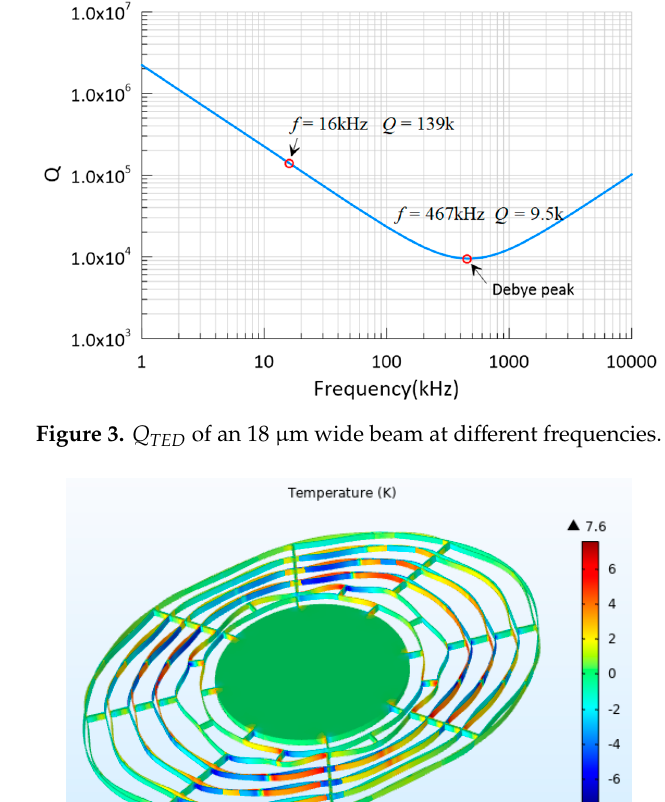
Q Figure 3. TED of an 18 μ m wide beam at different frequencies.